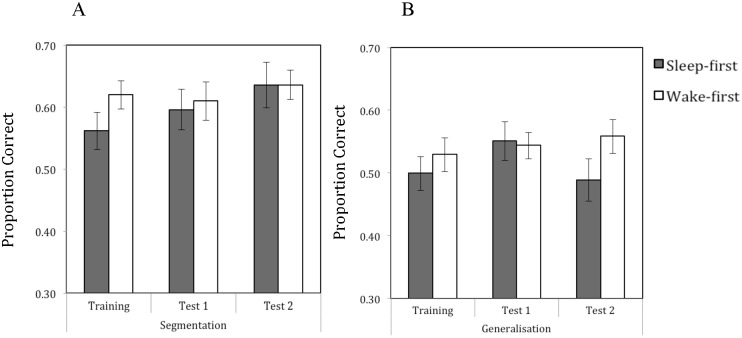
Mean performance scores on the segmentation (panel A) and generalisation (panel B) tasks immediately after training, and at each subsequent test phase, given for each consolidation condition.Error bars indicate Standard Errors.